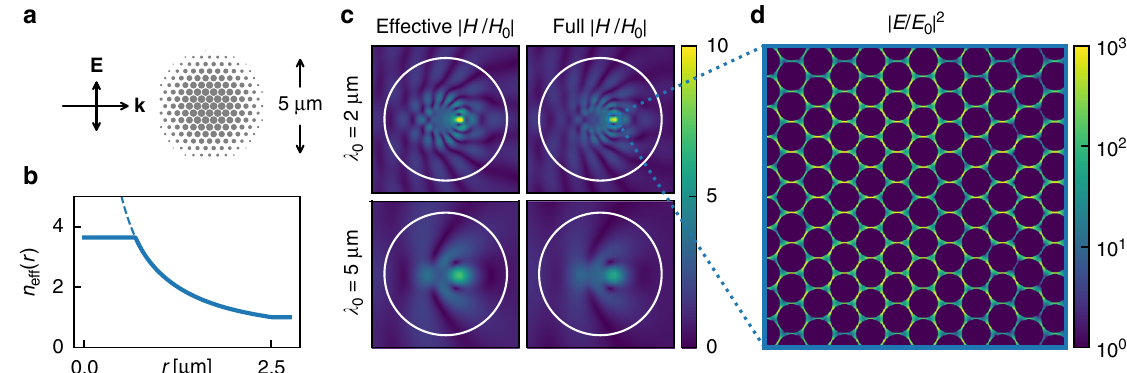
Fig. 6 Designing a gradient-index lens with ‘ doubly-enhanced ’ hotspots. a Schematic of a ‘ concentrator ’ gradient-index lens composed of gold nanocylinders on a triangular lattice with 50 nm site-to-site separation. b Effective index pro fi le of the concentrator lens, ideal (dashed) and achieved (solid). c Magnetic near- fi elds calculated using the effective geometry and the full geometry both con fi rm that plane waves are focused towards the origin of the lens. d Within the focal point of the lens, the combined focusing and squeezing of the electric fi eld produces ‘ doubly-enhanced ’ hotspots NATURE COMMUNICATIONS| (2019) 10:2118